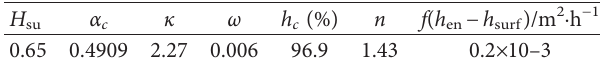
Figure 5: Test apparatus of moisture conduction [33]. Table 3: Parameters of humidity field.